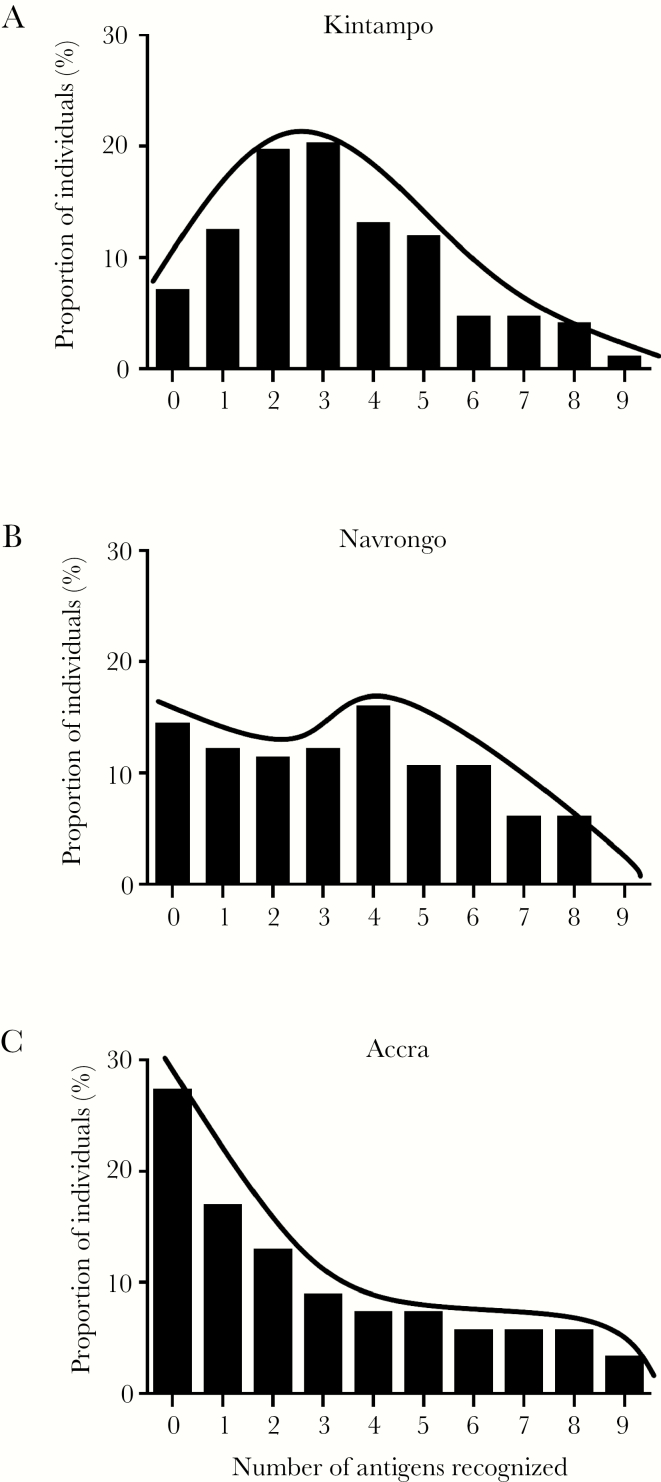
The breadth of antibody reactivity to multiple antigens varies across areas with varying transmission intensity. Breadth scores were calculated for each child based on the number of antibody responses. Distribution of the breadth of antibody reactivity of malaria-positive children was compared between Kintampo (N = 167), Navrongo (N = 131), and Accra (N = 125).